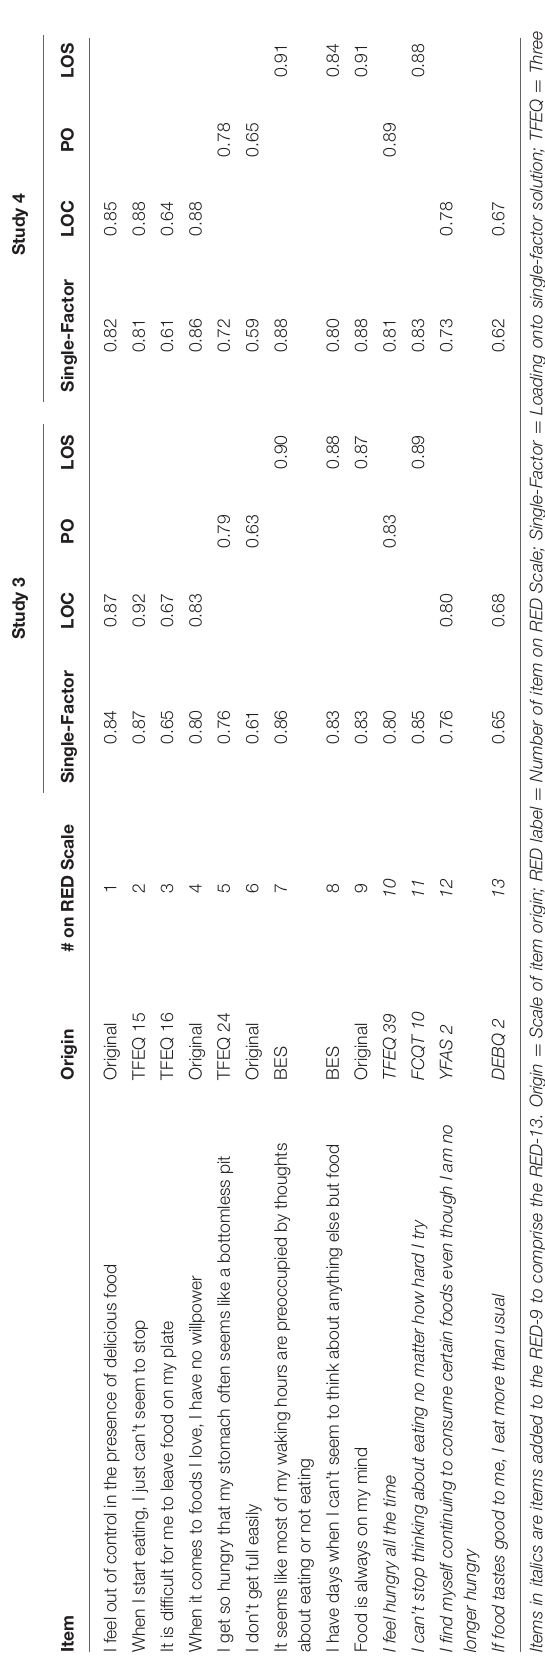
Table 4 ). As in Studies 1, 2, and 3, model fit improved with a 3- factor solution (3-factor model: X 2 = 60.022, df = 24, p <